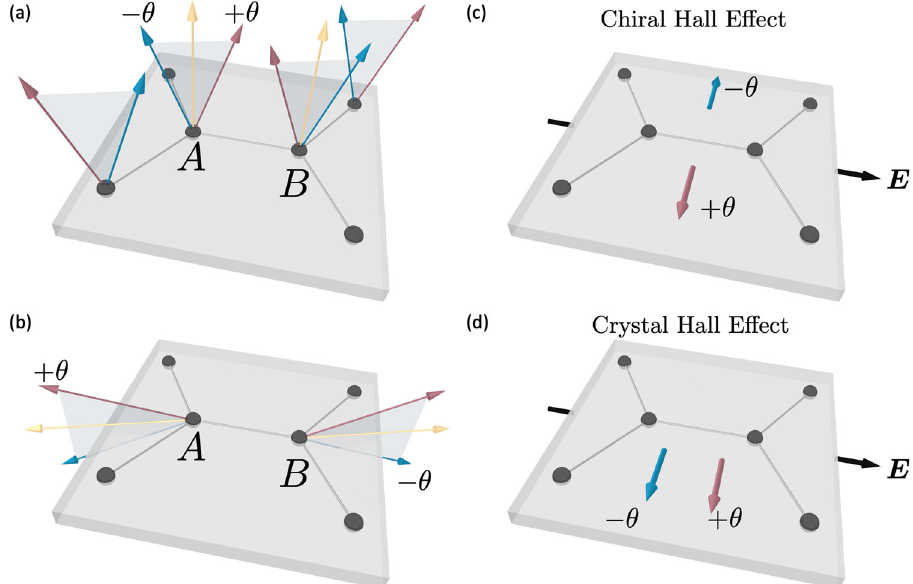
Fig. 1 Sketch of the de fi nition of crystal Hall and chiral Hall effects in canted ferromagnets and antiferromagnets. Once collinear ferromagnetic or antiferromagnetic order (light yellow arrows in a and b ) is broken by canting with positive ( + θ , red arrows) or negative ( − θ , blue arrows) sense of vector chirality, the modi fi cations in the electronic structure result in the modi fi cations of the anomalous Hall conductivity (AHC), σ xy ( θ ). The AHC can be (cid:2) (cid:3) = 2, ( d ), and the chiral Hall (antisymmetric, θ -odd) part decomposed into the crystal Hall (symmetric, θ -even) part, σ s xy ¼ σ xy ðþ θ Þ þ σ xy ð(cid:2) θ Þ (cid:2) (cid:3) σ a ¼ σ ðþ θ Þ (cid:2) σ ð(cid:2) θ Þ = 2, ( c ). In c and d the red and blue arrows correspond to the direction of the Hall current for positive and negative chirality in an xy xy xy applied electric fi eld